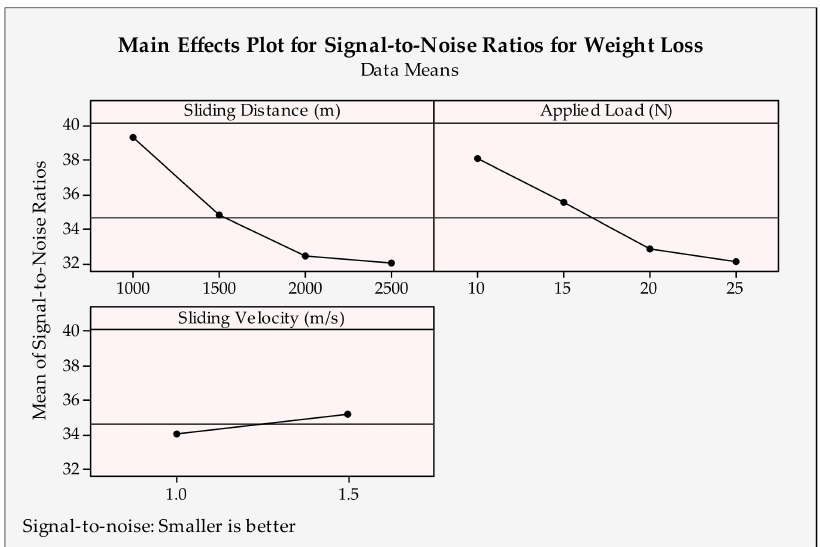
Figure 11. Signal-to-noise ratios of weight loss for tribological